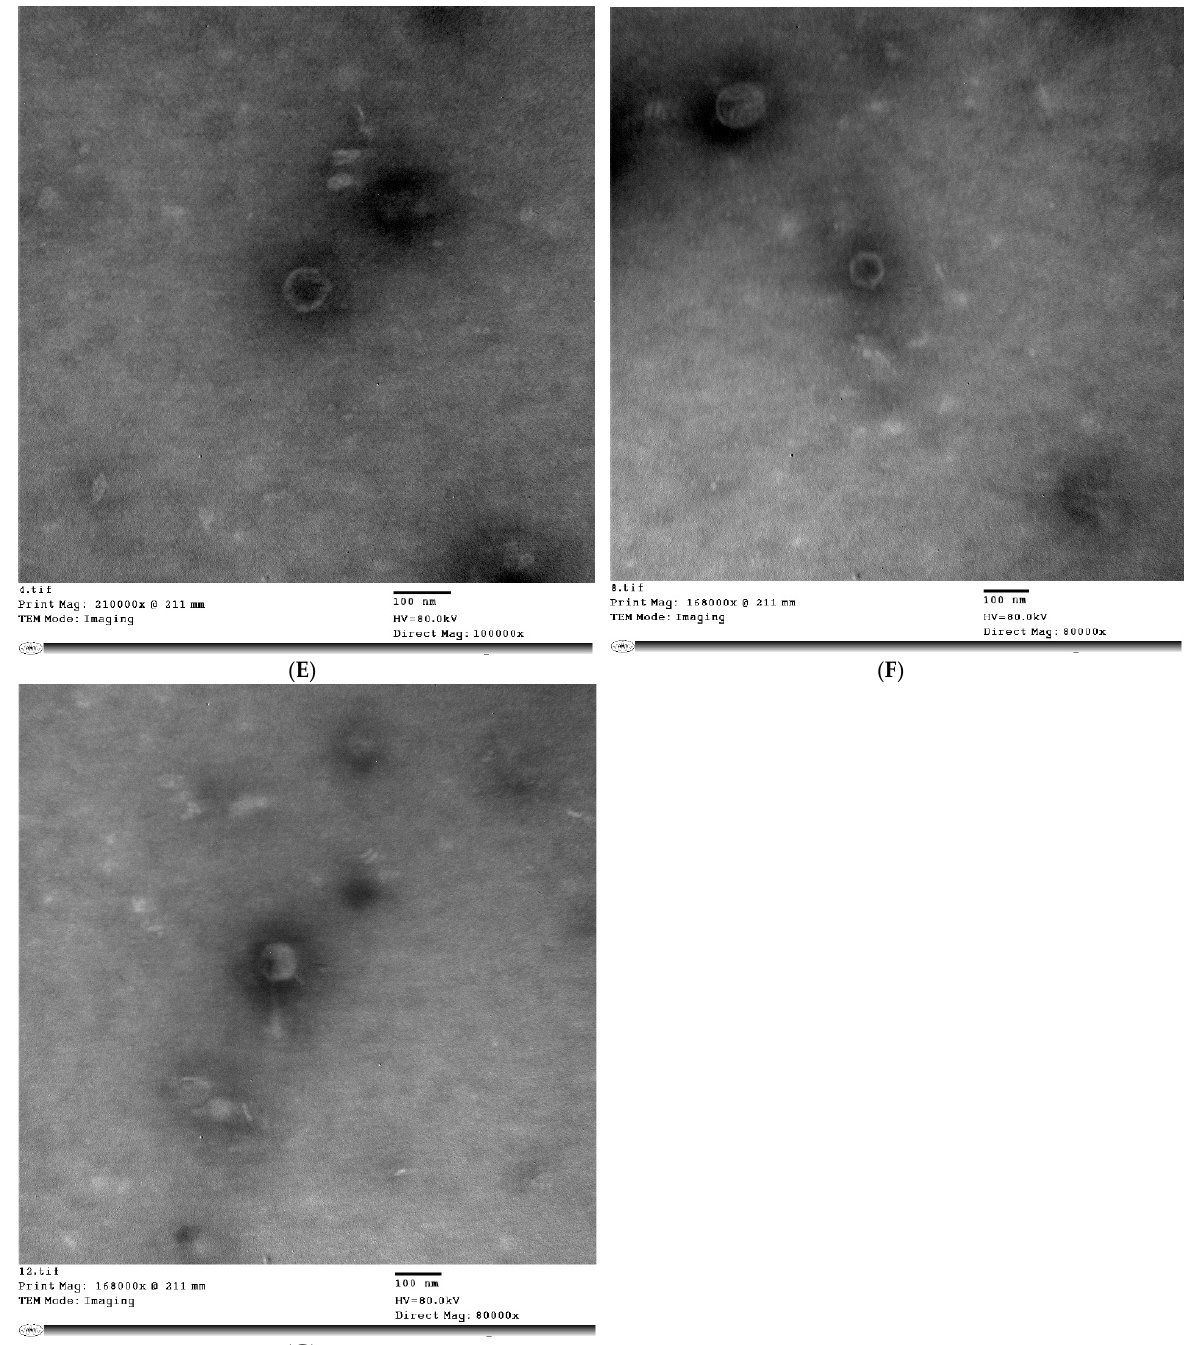
Figure 1. Transmission electron microscopy (TEM) micrographs of E. coli phage particles (STEC P1– STEC P4) stained negatively by 2% ( w / v ) phosphotungstate at pH 7.2. STEC P1: ( A ) direct magnifi-